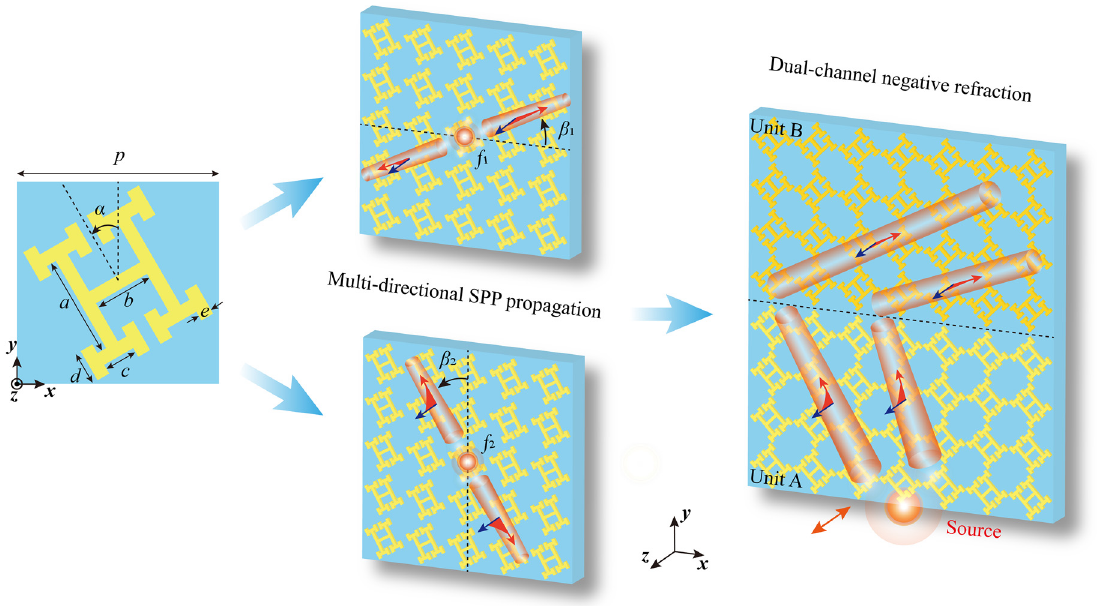
Figure 1: Schematic diagram of the proposed twisted HMSs consisting of a dielectric/Cu bilayer, where p = 9 mm, a = 4.5 mm, b = 2.6 mm, c = d = 1.6 mm, and e = 0.56 mm, and the counterclockwise rotation angle of the unit cell is α